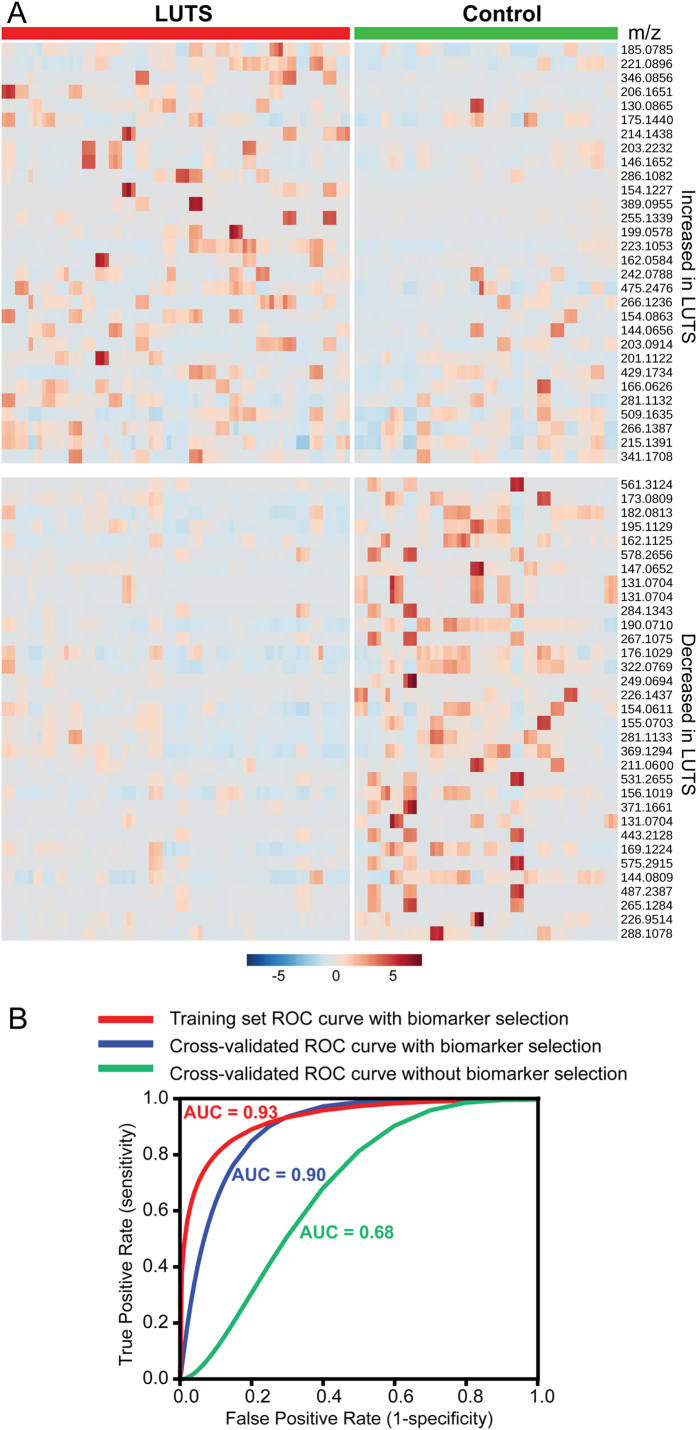
Heat map (A) and ROC analysis (B) using 63 identified metabolites. The heat map is grouped by disease status and the trend of relative quantification. Shades of red and blue represent metabolite peak areas relative to the median. ROC analysis was carried out to evaluate classification model established with linear SVM algorithm and leave-one-patient-out cross-validation.